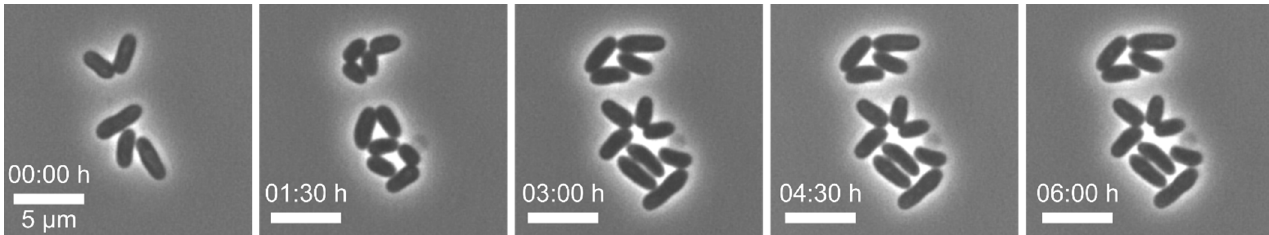
Figure 6. Microscopic images of C. glutamicum with stagnating growth after three hours of cultivation (scale bar = 5 μ m).